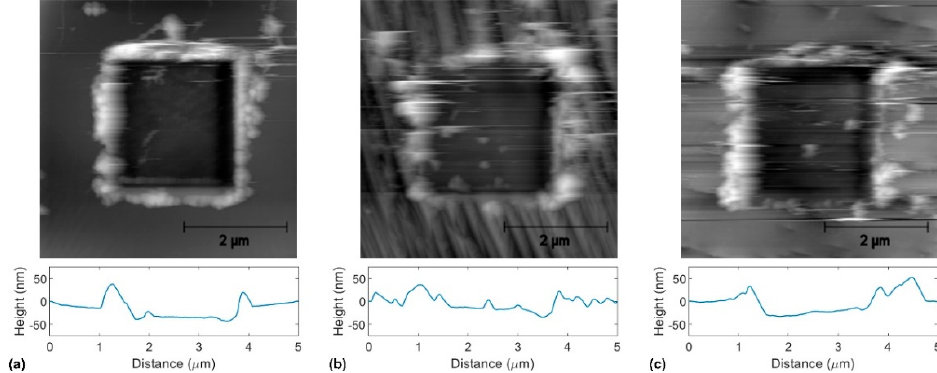
Figure 8. Topographical images recorded by noncontact AFM after tribological testing of ( a ) annealed copper, ( b ) graphene-coated copper, and ( c ) BN-coated copper.